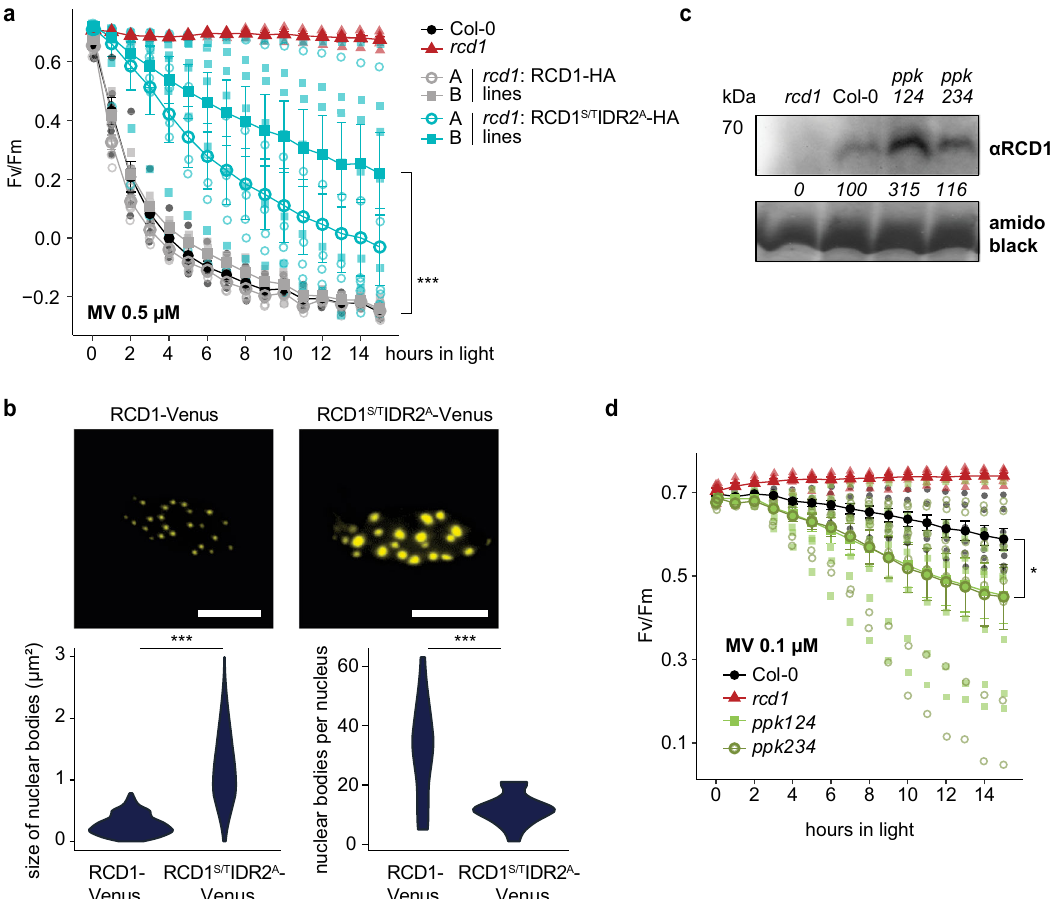
Fig. 4 Phosphorylation by PPKs regulates RCD1 function and protein level. a RCD1 S/T IDR2 A -HA variant does not fully complement rcd1 -speci fi c tolerance to MV. PSII inhibition (Fv/Fm) by MV was measured in indicated lines using 0.5 μ M MV. For each experiment, leaf discs from at least four individual 3-week-old rosettes were used. The experiment was performed three times with similar results. Mean ± SD are shown. *** – P value < 0.001 with Tukey corrected post hoc test at the selected time point between rcd1 : RCD1 S/T IDR2 A -HA (line A) and rcd1 : RCD1-HA (line A) lines. Full source data and statistics are presented in Supplementary Data 1. b RCD1-Venus and RCD1 S/T IDR2 A -Venus are localized to distinct NBs. 10-day-old plate grown seedlings were soaked in 0.05% Tween-20 overnight at 4 °C and the subnuclear localization of RCD1-Venus and RCD1 S/T IDR2 A -Venus was analyzed by confocal microscopy. Representative images are shown. For quanti fi cation the images were acquired from 4 seedlings in each of which 4-5 nuclei from mesophyll cells were imaged as a Z-stack and then condensed by maximum projection. Violin plot is shown. (*** – P value < 0.001 one-way ANOVA). Scale bars represent 10 µ m. Full source data and statistics are presented in Supplementary Data 1. c RCD1 accumulation in ppk triple mutants is higher than in Col-0. RCD1 level was assessed in total protein extracts from 3-week-old plants by immunoblot analysis with RCD1-speci fi c antibody. The signal was quanti fi ed using ImageJ. The abundance in percent relative to Col-0 (100%) is shown under the immunoblot panel. Rubisco large subunit detected by amido black staining is shown as a control for equal protein loading. d ppk triple mutants are more sensitive to MV than Col-0. PSII inhibition (Fv/Fm) by MV was measured in indicated lines using 0.1 μ M MV. For each experiment, leaf discs from four individual 3-week-old rosettes were used. The experiment was performed three times with similar results. Mean ± SD are shown. * – P value < 0.05 with Tukey corrected post hoc test at the selected time point between ppk124 and Col-0. Source data and statistics are presented in Supplementary Data